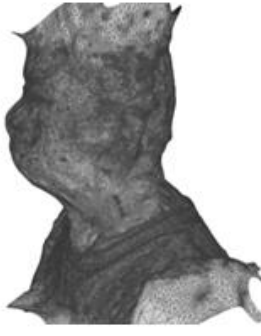
Figure 10. The result of photo reconstruction.